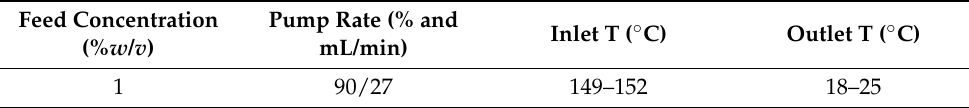
Table 1. Advanced spray drying parameters for spray dried (SD) TMP powders using methanol